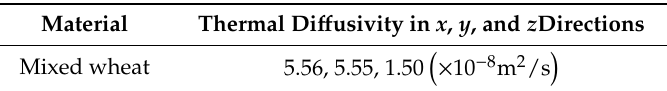
Table 1. Physical properties of stored